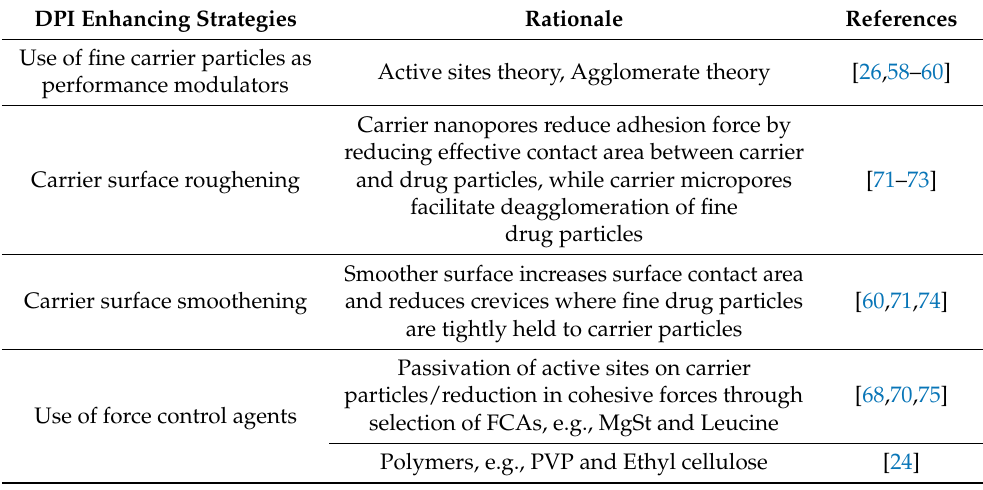
Table 2. Key FPF-enhancing